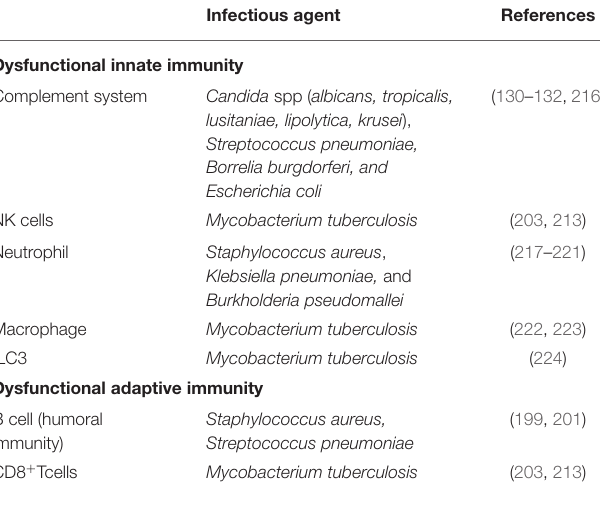
TABLE 3 | Dysfunctional immune system in T2DM patients promotes the pathogenesis of infections. Infectious